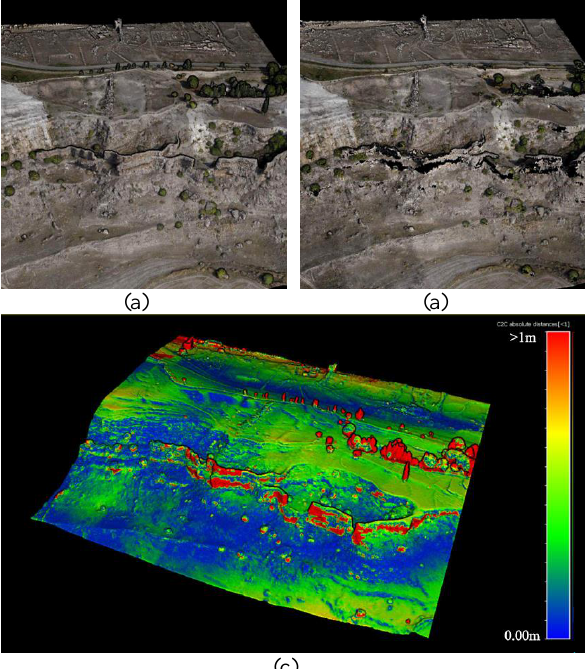
Figure 7. Two bird's-eye views of the point-based DSM over the Hierapolis site (a) and particularly the limestone hill (b) The Figure 8 show a visual comparison of two point clouds models: without gaps in the left, and generated with holes for lack of information during the cloud densification, in the right. The two models were compared using a C2C algorithm that provides residuals ranging to about 1 metre for the architectural structures of a certain height, as well as trees.